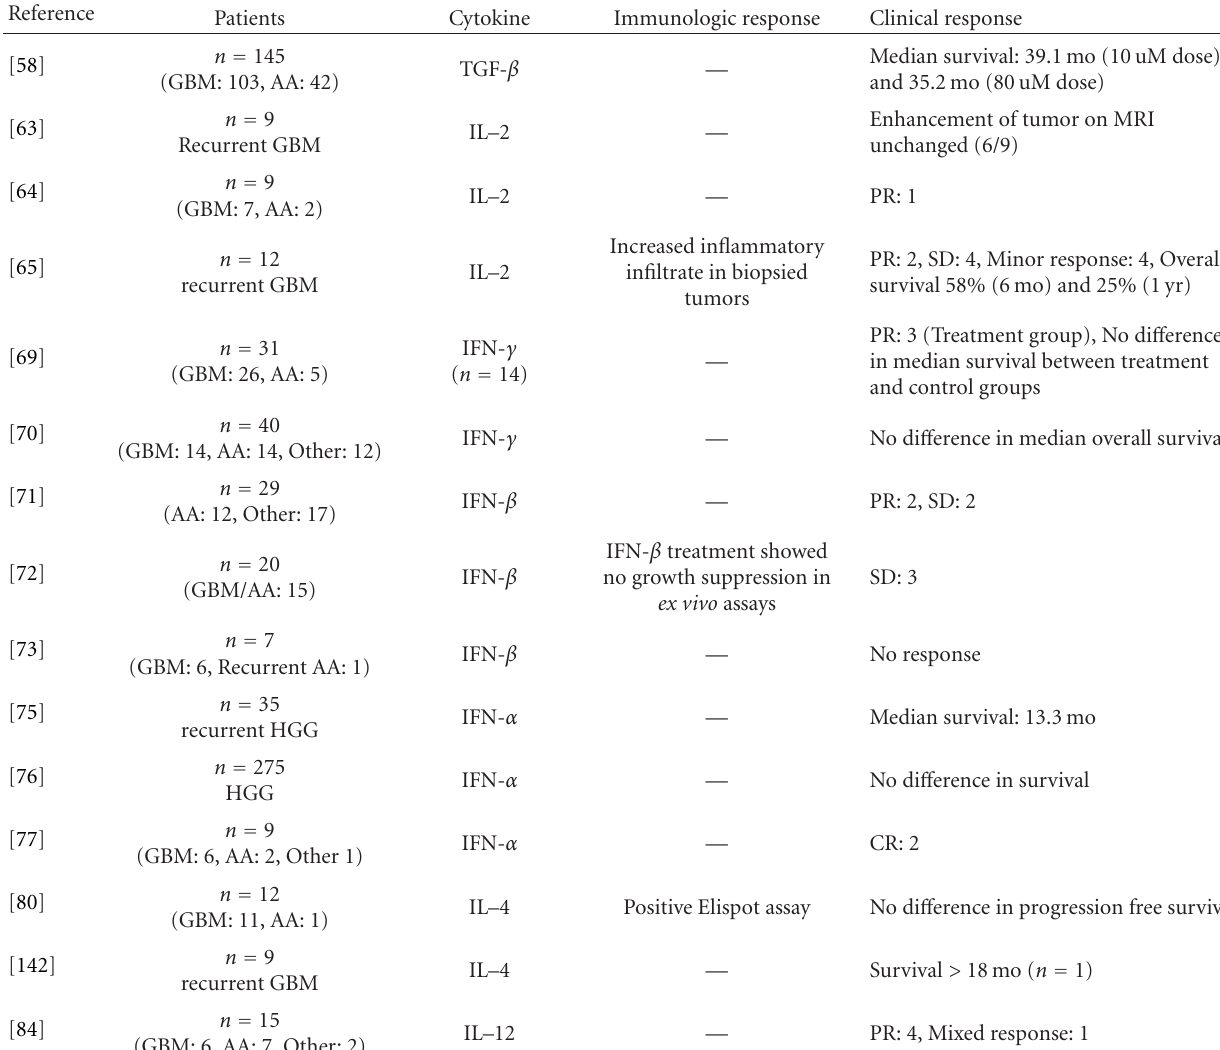
Table 1: Selected clinical trials using cytokine